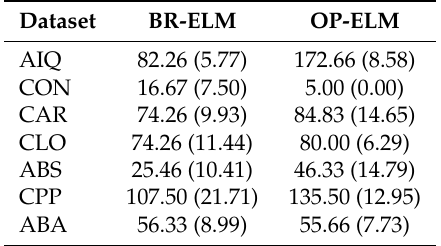
Table 13. Result of regression test—number of